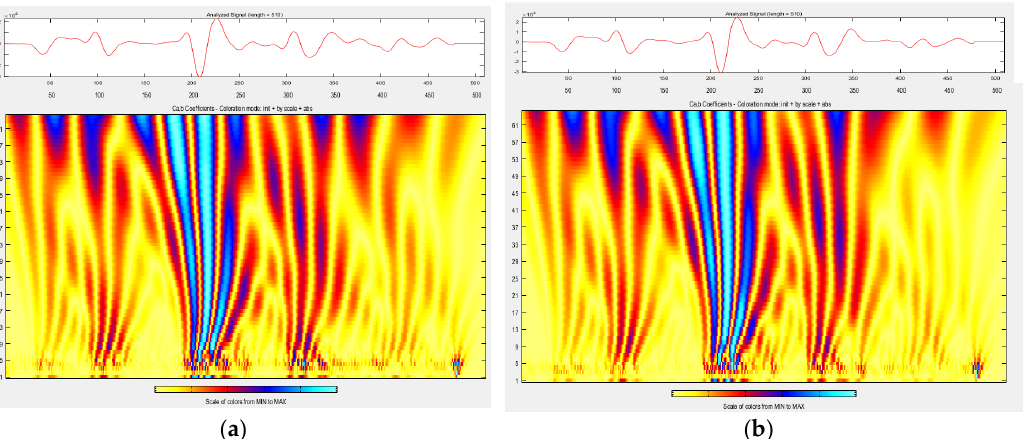
Figure 9. Wavelet analysis of A-scan from measurements in conditions ( a ) wIII (temp. − 5 °C, water film on the slab surface); ( b ) wIV (temp. − 5 °C, thin layer of ice on the slab surface).